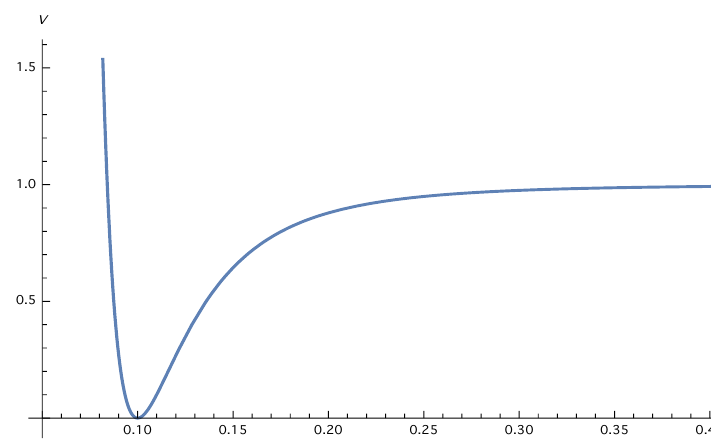
( φ ) . Since V ∝ | w | 2 this potential X X